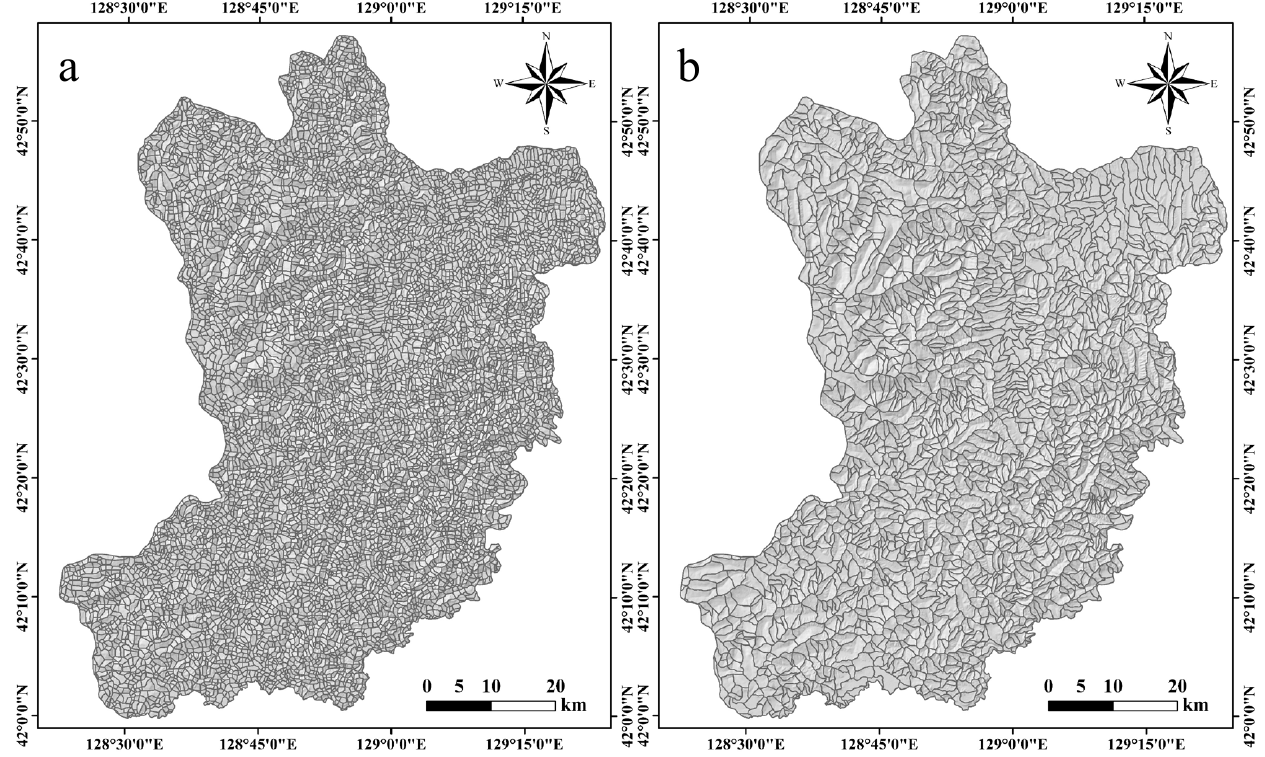
Figure 3. The mapping unit classification results: ( a ) slope unit, and ( b ) watershed